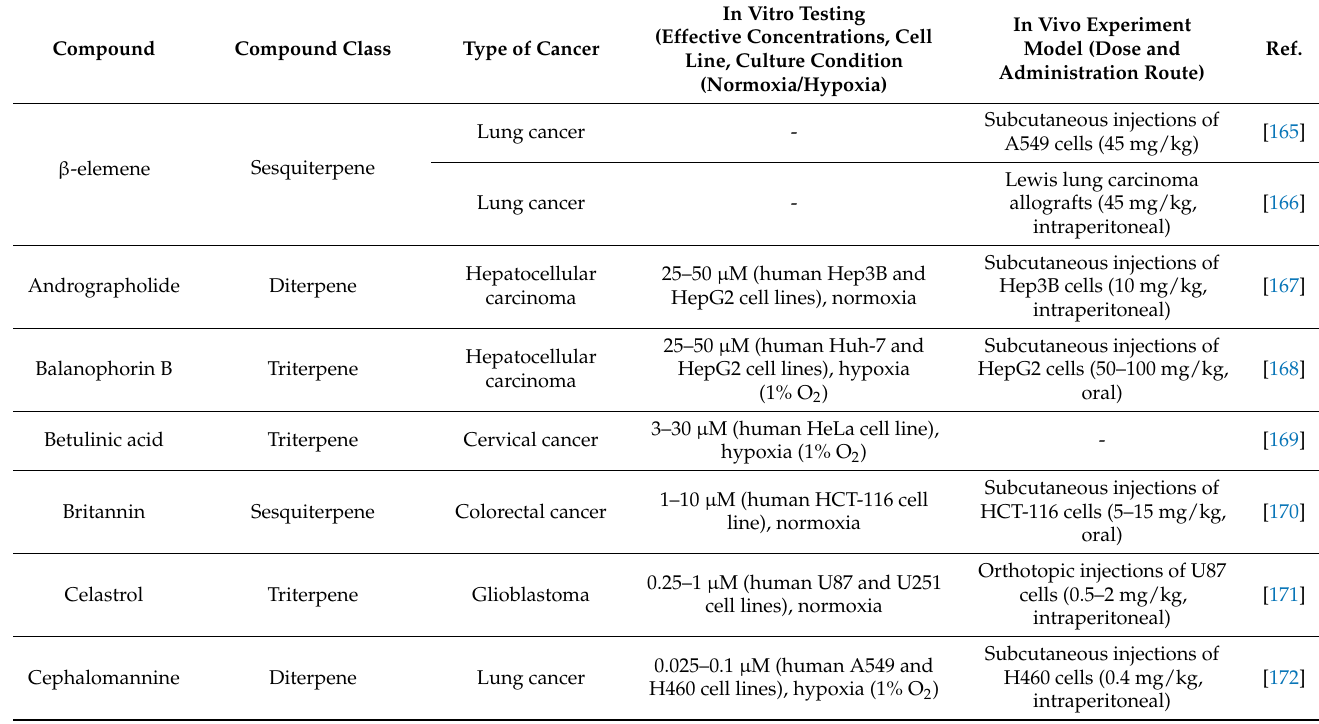
Table 3. The list of terpene compounds restricting HIF-1 α in cancer (alphabetical